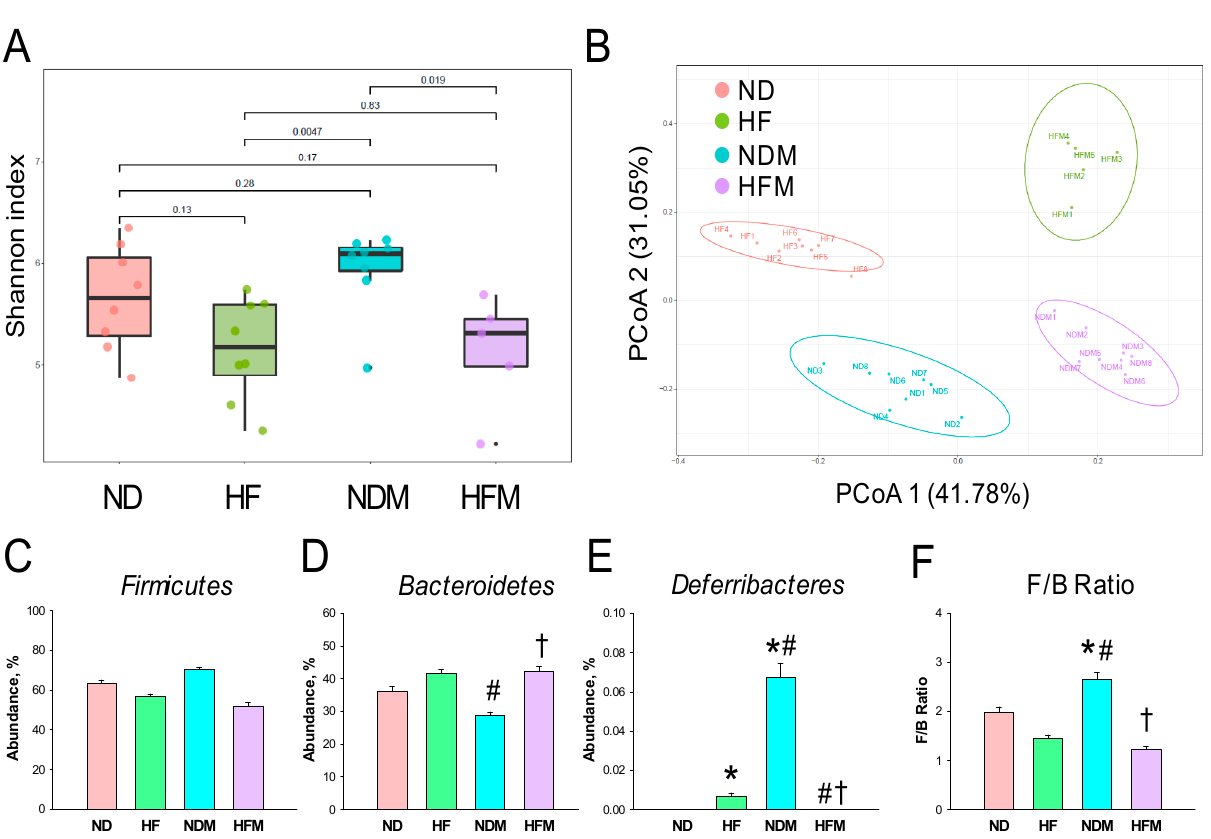
Figure 3. Effect of high-fructose diet (HF) and minocycline administration (M) on the gut microbiome in male offspring. ( A ) Shannon’s α -diversity indexes. ( B ) β -diversity using the Principal Coordinate Analysis (PCoA). Relative abundance of the phylum ( C ) Firmicutes , ( D ) Bacteroidetes , and ( E ) Deferribacteres . ( F ) The Firmicutes to Bacteroidetes (F/B) ratio. Data are shown as means ± SEM; N = 5–8/group. * p < 0.05 vs. ND; # p < 0.05 vs. HF; † p < 0.05 vs. NDM.